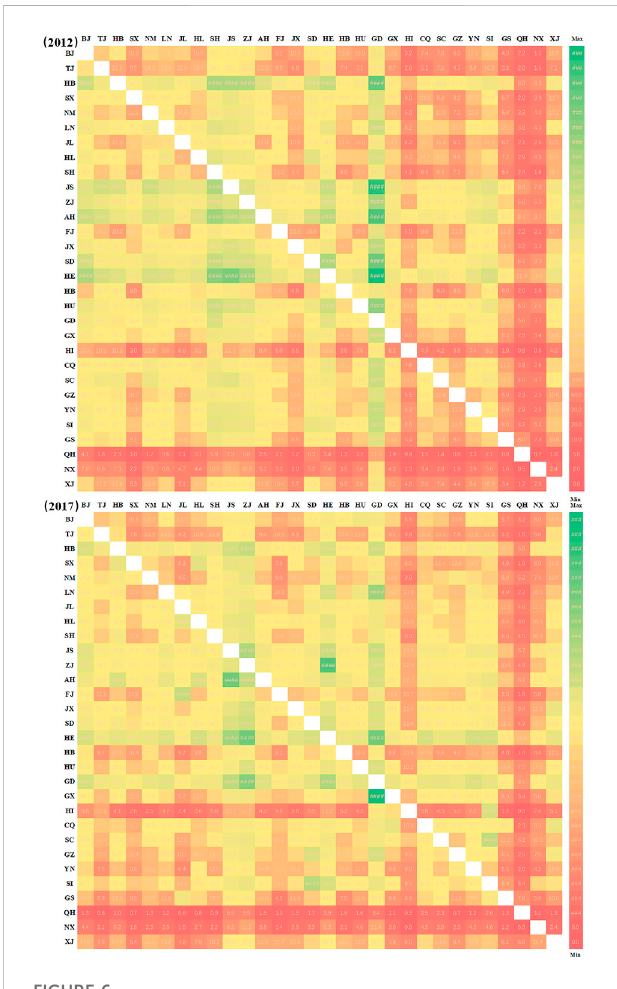
FIGURE 6 Inter-provincial transfer matrix of embodied employment from 2012 to 2017 (In the fi gure, the block color changing from green to red indicates an increase of the amount of embodied employment